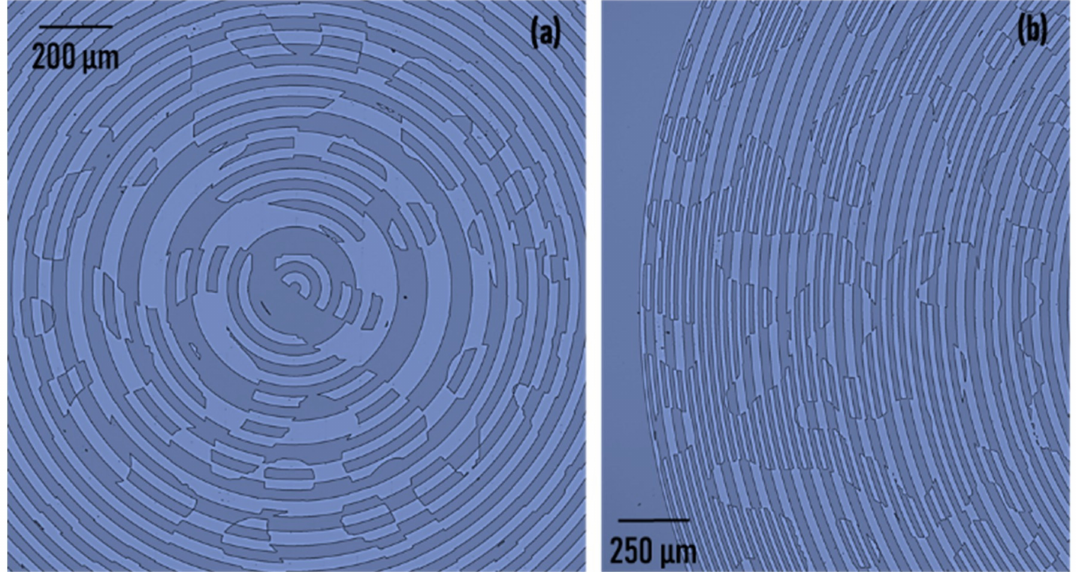
Figure 2. Optical microscope images of the ( a ) central and ( b ) outermost part of the HDOE fabricated using electron beam lithography. The dark blue color indicates the resist remained and the light blue color indicates the resist was